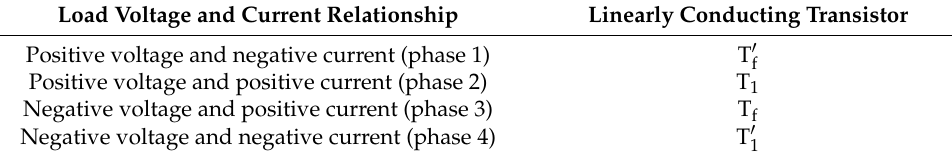
Table 1. Conduction of transistor.